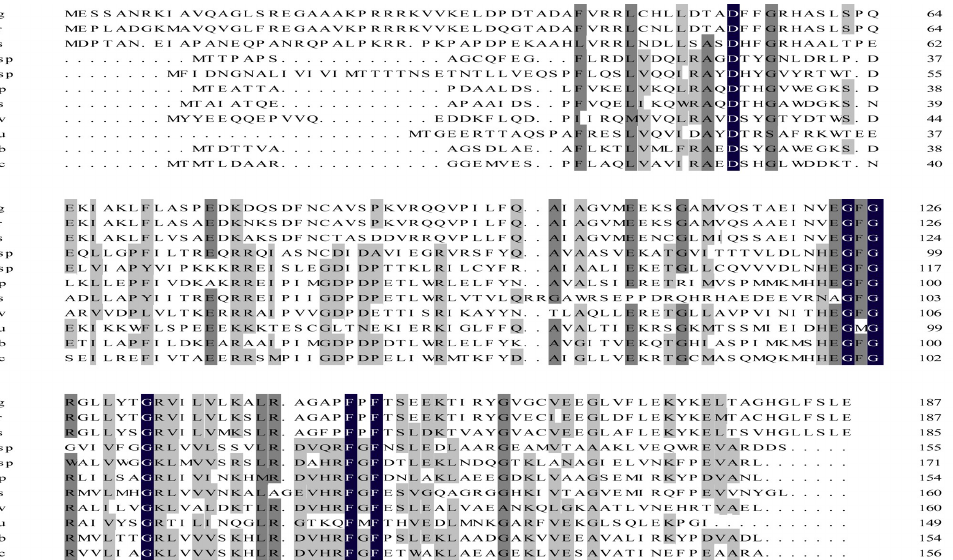
Figure 2. Comparison of the predicted amino acid sequences of the Paenibacillus graminis (Pg) Orf1 proteins with analogous gene products from Paenibacillus sabinae (Ps), Paenibacillus riograndensis (Pr), Clostridium ultunense (Cu), Frankia sp. EuIK1(Fsp), Herbaspirillum seropedicae (Hs), Cyanothece sp. ATCC 51,142 (Csp), Rhodopseudomonas palustris (Rp), Rhodobacter capsulatus (Rc), Azotobacter vinelandii (Av) and Azospirillum brasilense (Ab). A black background indicates conserved residues in all aligned sequences, dark grey indicates conserved residues in at least 75% of the aligned sequences, and light grey indicates conserved residues in at least 50% of the aligned sequences.